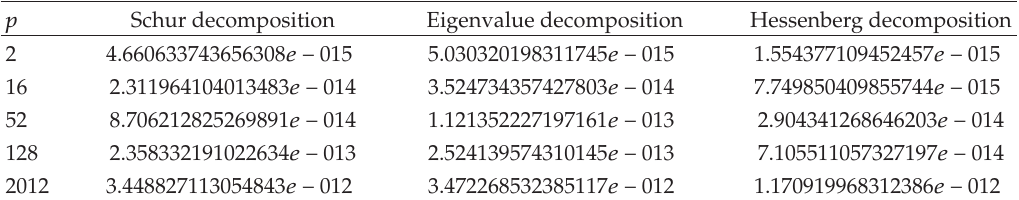
Table 1: Comparison residual error for computing the p th root of Random